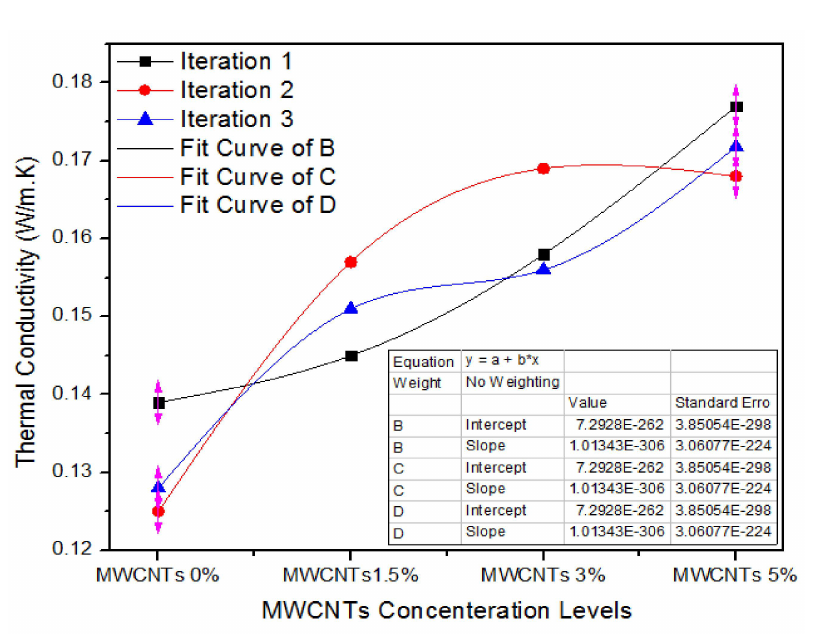
the measured count parameters are 0.65, 0.61 and 0.69 MPa. Similarly, for 3.0% MWCNTs, the measured counts are 0.71, 0.75 and 0.68 MPa internal adhesion parameters. All the three counts have I.B values of 0.73, 0.75 and 0.9